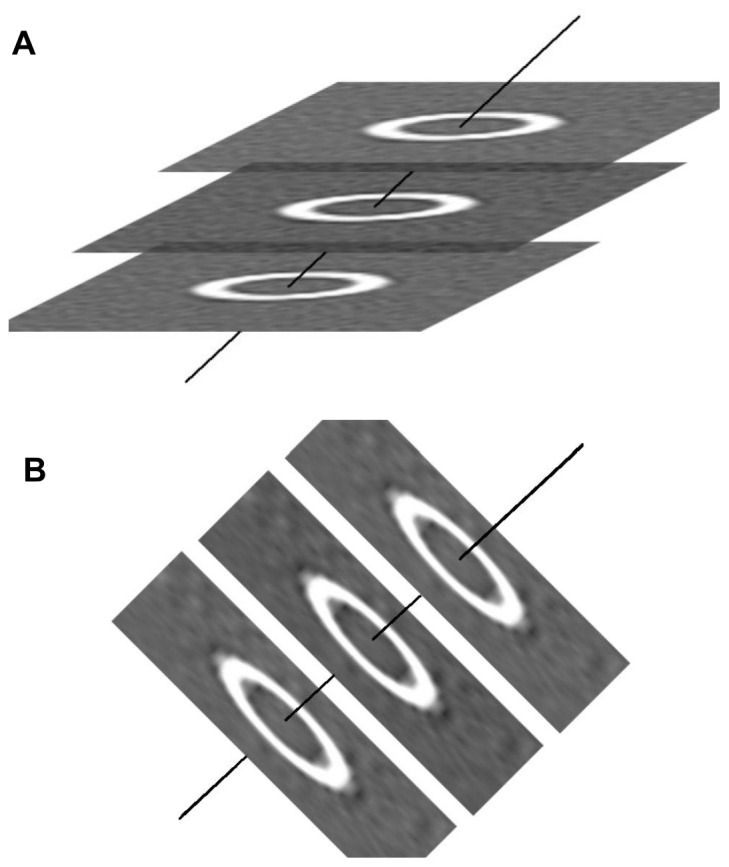
Schema describing the method of airway dimension measurement.A: Using sequential CT slices which included a section of the target tube, the center (solid) line of the tube was calculated by linking the center points of sections on each slice. B: Images were constructed perpendicular to the center line.